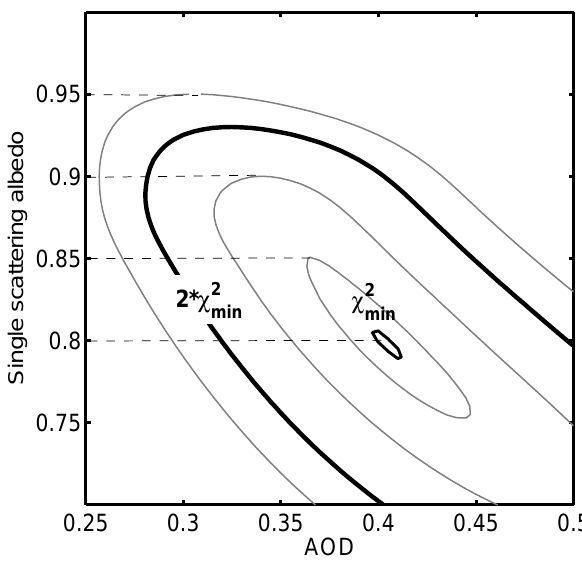
Figure 16. Contours of χ 2 in the AOD- ω space for the ODS test signal. The minimum of χ 2 is found for AOD = 0.4 and ω = 0 .